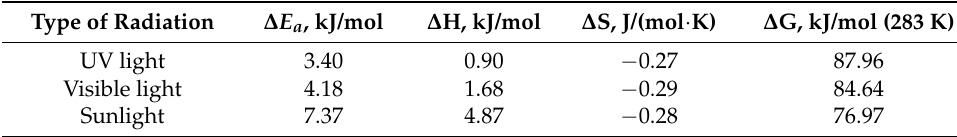
Figure 6. Arrhenius plots ( left ) and Eyring’s plots ( right ) for determining the thermodynamic characteristics of AY degradation reaction under ( a ) UV light, ( b ) visible light and ( c ) sunlight. Table 1. Thermodynamic parameters of the degradation of